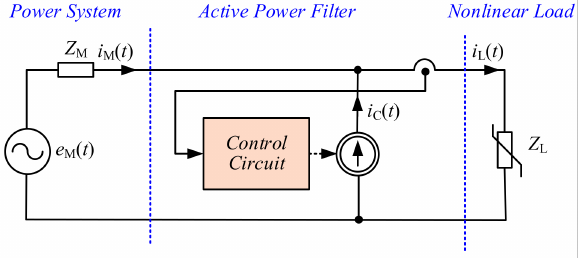
Figure 1. Block diagram of